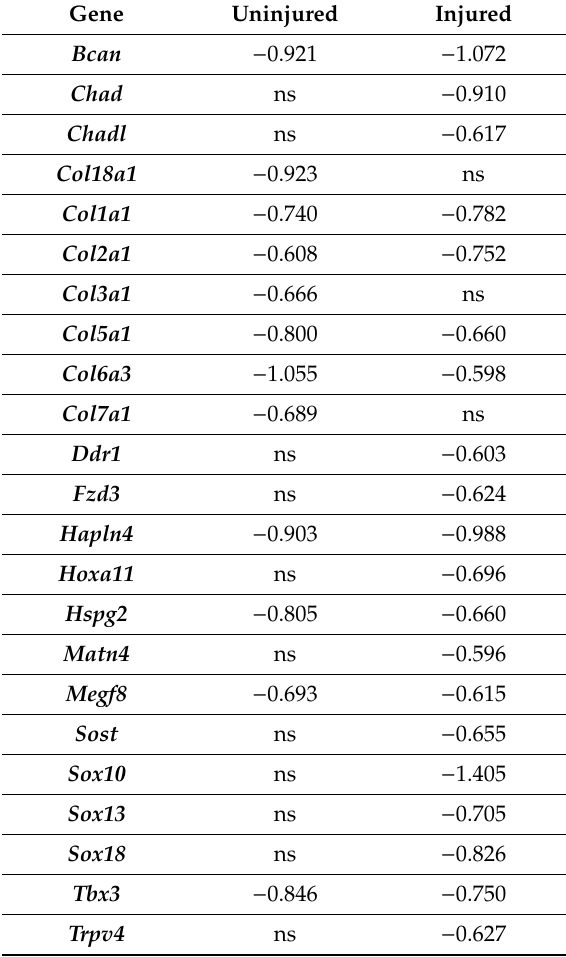
Table 2. Bone and cartilage gene overlap between the AB and VEH groups, showing expression levels. Fold change (log2 scale) values are shown in the table (FDR < 0.05 for all genes). Changes that were not significant are denoted as ns. Gene Uninjured Injured